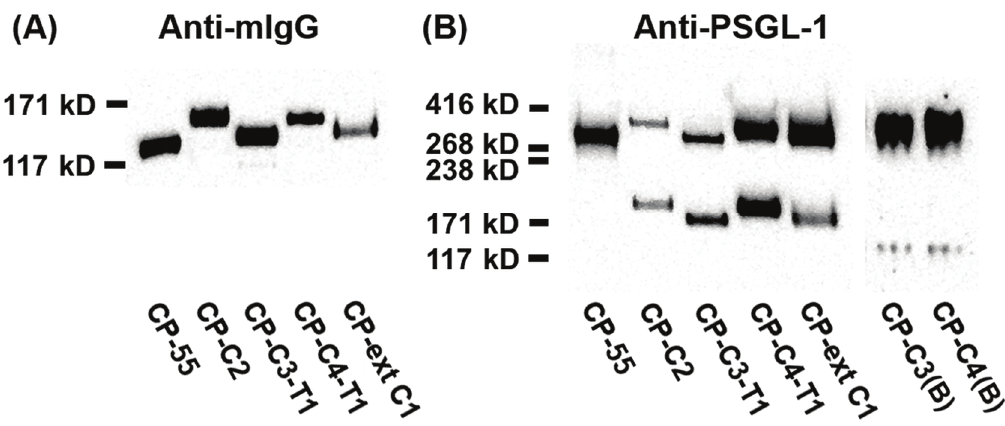
Figure 2. SDS-PAGE and Western blot analysis of purified PSGL-1/mIgG2b carrying (cid:2)2,3-sialylated O -glycan core structures. For Western blot analyses, 0.2 μ g of protein were loaded and analyzed on SDS-PAGE under reducing ( A ) or non-reducing ( B ) conditions. After blotting, membranes were probed with anti-mIgG Fc ( A ) and anti-PSGL-1 ( B ). The